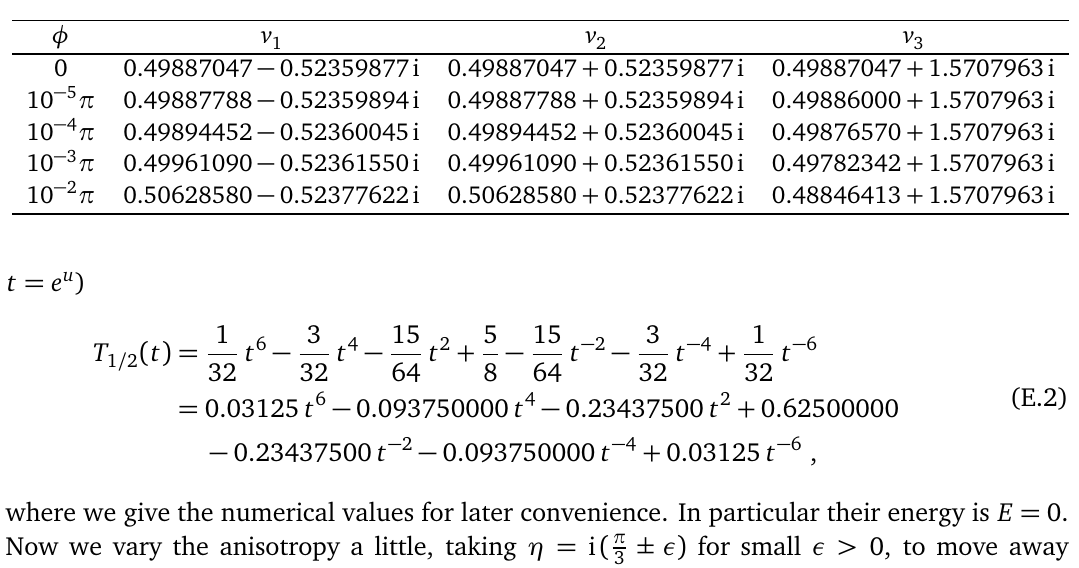
Table 3: Numerical results for the Bethe roots of the Bethe vector |{ v }〉 when introducing a small twist φ . ing |{ α FM 2